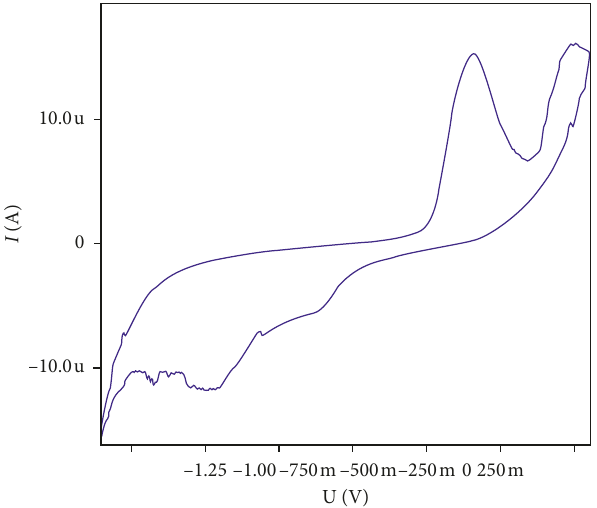
Figure 4: Cyclic voltammograms at a modified CPE with 5% dep values. Bi 2 O 3 (w/w) in the supporting electrolyte mixture of 0.1 M KI and acetate buffer. Conditions: E dep � − 1.2 V; t dep � 120 s;